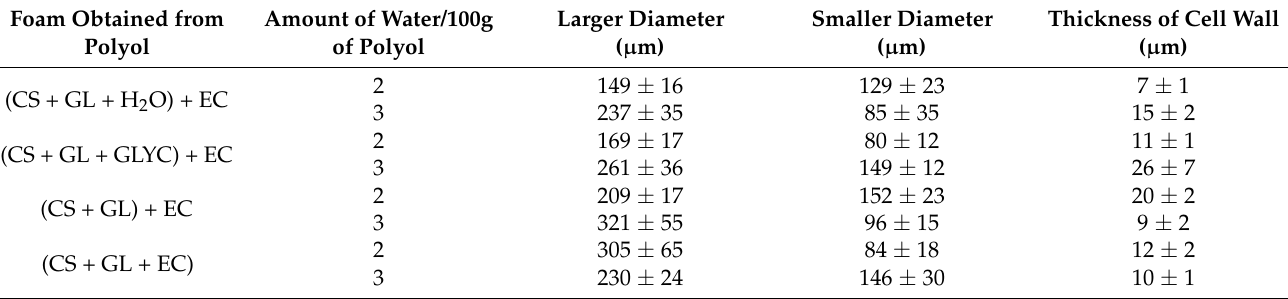
Figure 6. The density of the obtained polyurethane foams (determined with ± 2.0% accuracy). The water content in the foam composition per 100 g of polyol is shown in the insert. Table 6. Results of micrograph